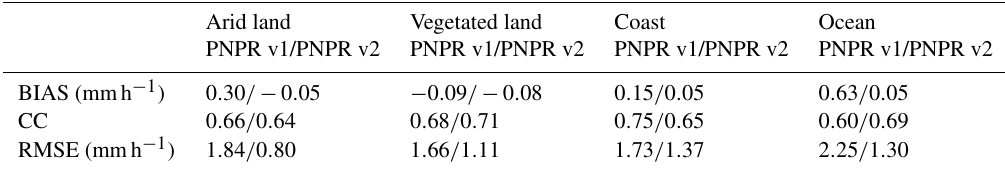
Table 5. Statistical indexes of the comparison of PNPR v1 and PNPR v2 vs. TRMM-PR retrievals. Arid land Vegetated land Coast